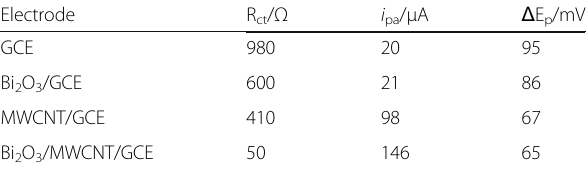
Table 1 Parameters for modified electrodes